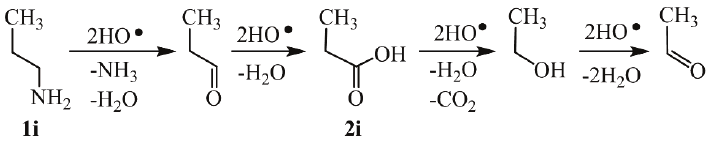
Figure 8. Degradation of 1-propylamine ( 1i ) and propanoic acid ( 2i ) by HO • radical.